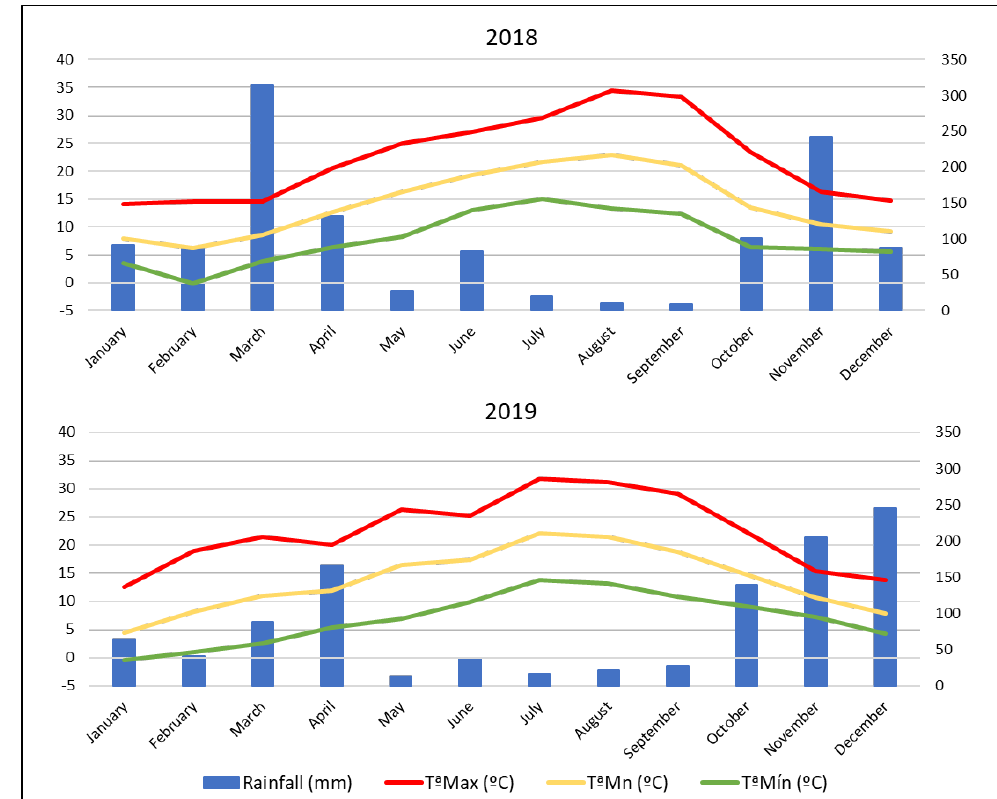
Figure 1. Climatic conditions in 2018 and 2019 vintages. Max T, Mean T, and Min T are average values of the maximum, mean, and minimum temperatures, respectively.